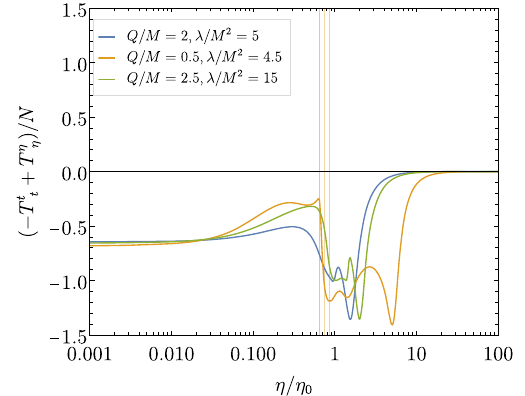
η Fig. 20 Thequantity ( − T t t + T η )/ N isshownversus η/η 0 forcoupling function(iii).Here η = 0 referstoanequator.Theverticallinesindicate the respective throat